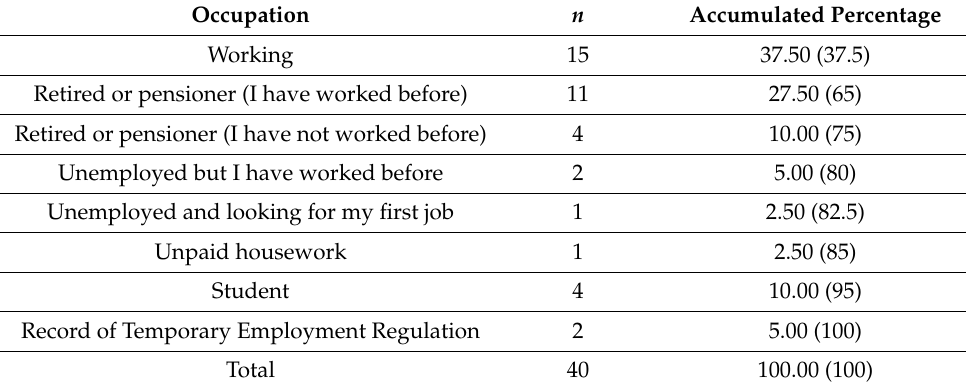
Table 2. Distribution of the sample according to their